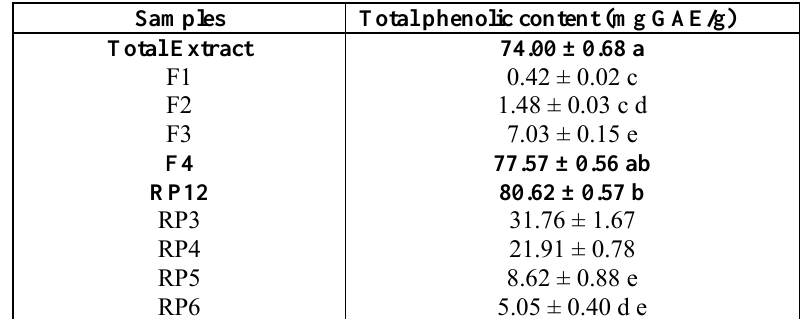
Table 3. Total phenolic content of C. perpuchrum and of